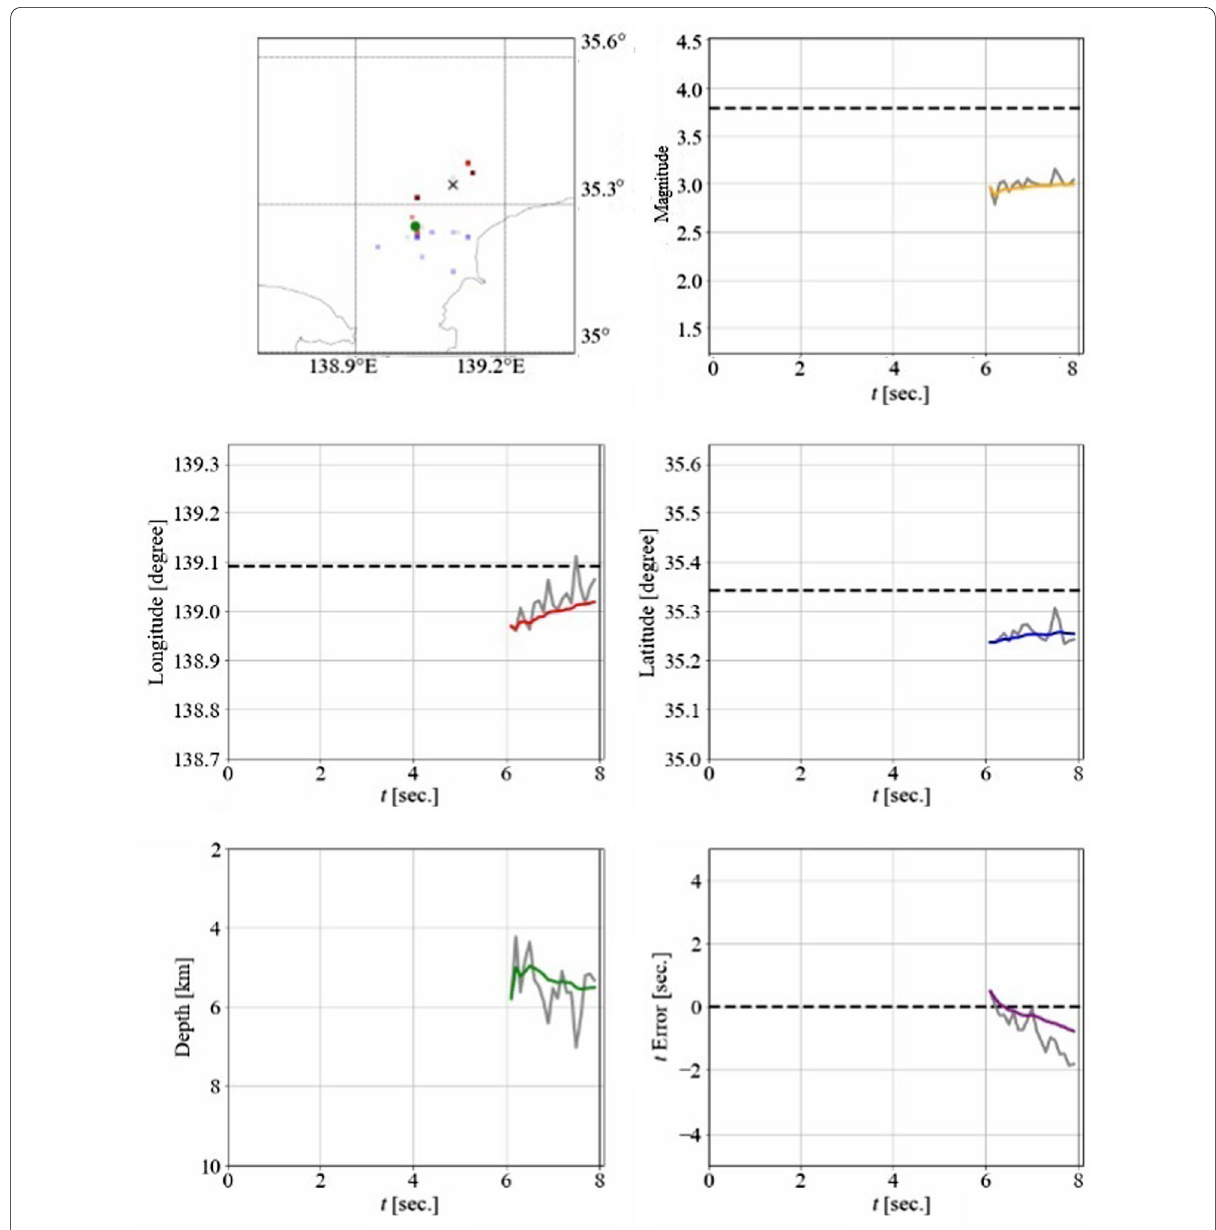
Fig. 9 Same as Fig. 5 but for noisy case. For details of figures see caption to Fig.